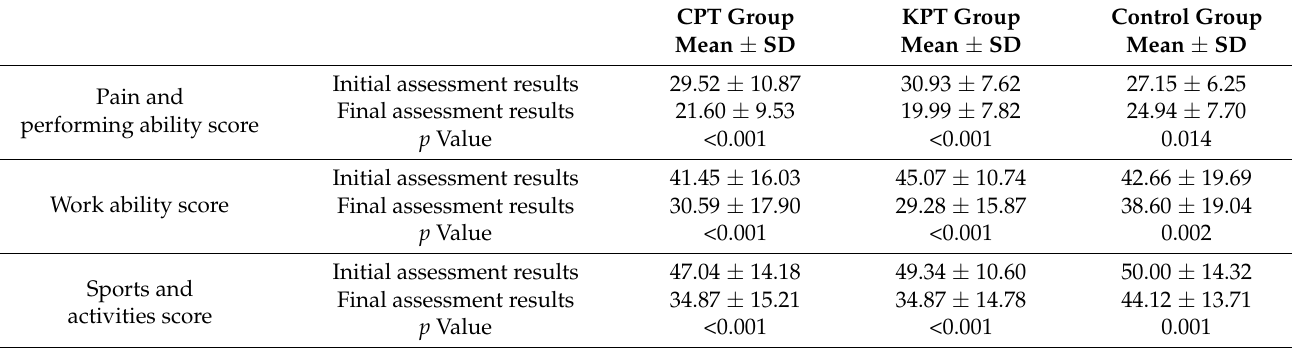
Table 4. Intra–group comparative analysis of the DASH Outcome